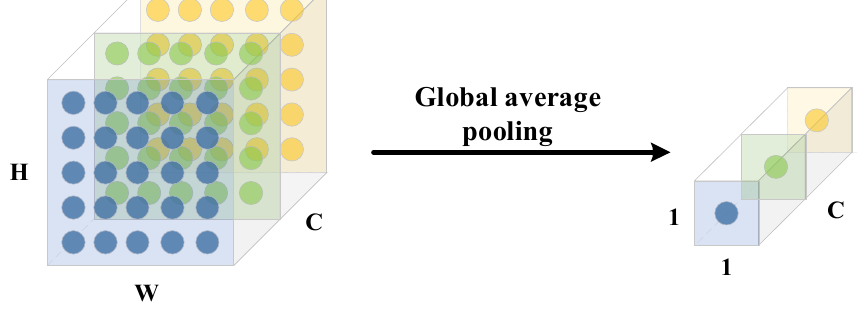
Figure 6. Global average